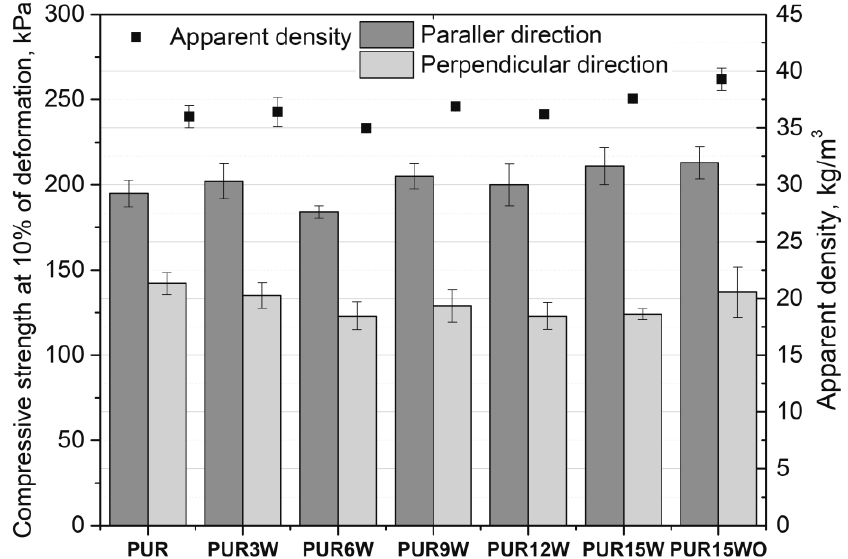
Figure 8. Apparent density and compressive strength of foams modified with vermiculite.